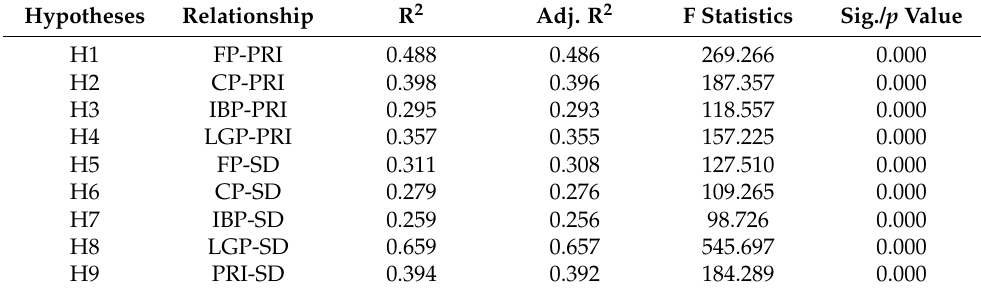
Table 6. Regression analysis.